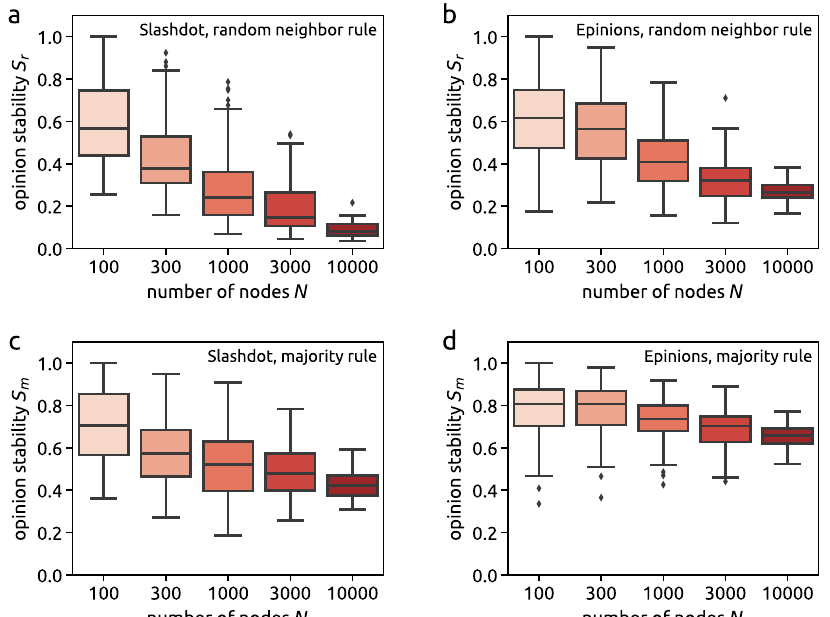
Fig. 7 Scaling of opinion stability in empirical worlds. Opinion stability achieved in subsets of progressively increasing size by the random neighbor rule ( a , b ) and the majority rule ( c , d ). Subsets have been obtained by sampling from corresponding empirical signed networks. The boxplots summarize opinion stability values obtained for 100 independent seed opinions (boxes show quartiles of the data and whiskers extend to 1.5 of the inter-quartile range; outlier data points beyond the whisker range are shown individually). In parallel with the results on synthetic relation networks, opinion stability decreases with N (opinion stability – world complexity tension). The decrease is slower for the majority rule than for the random neighbor